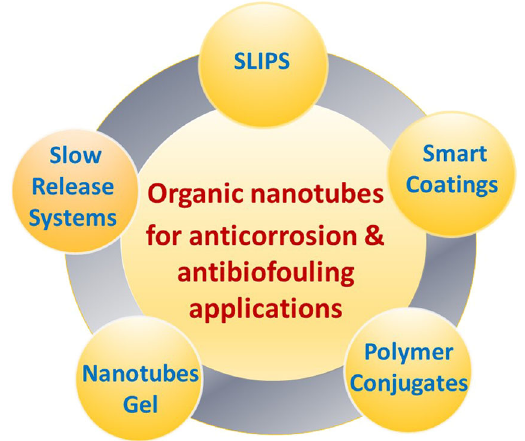
Fig. 1 A scheme showing the application